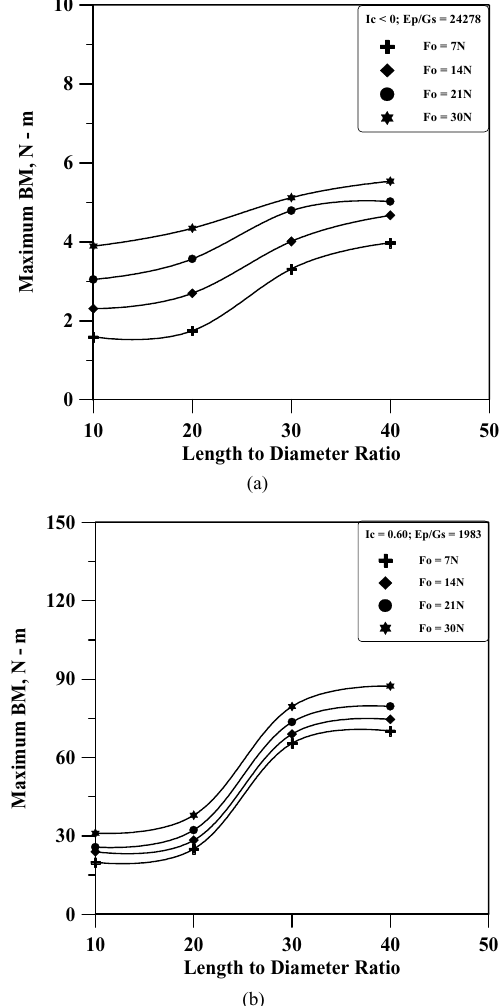
Fig. 17. Variation of maximum dynamic BM of piles with pile length at (a) I c ≈ 0.0 (b) I c = 0.60). z md = 1 . For L/d (cid:1) 30 , d